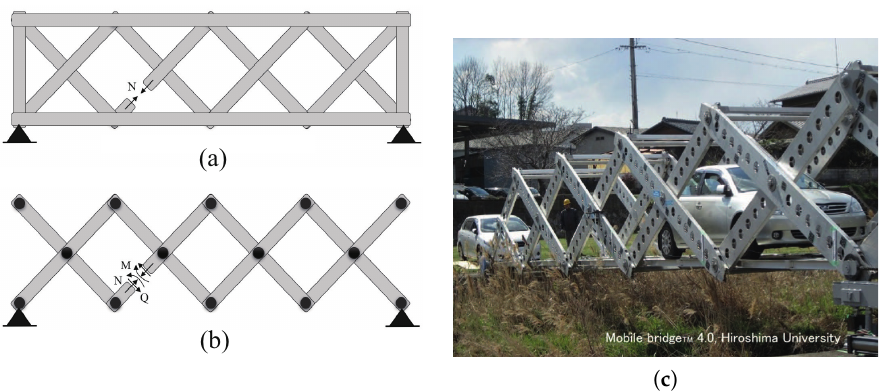
Figure 3. Types of emergency bridges. ( a ) Double Warren truss (DWT). ( b ) The scissors-type bridge (SCI). ( c ) The smart bridge [20].